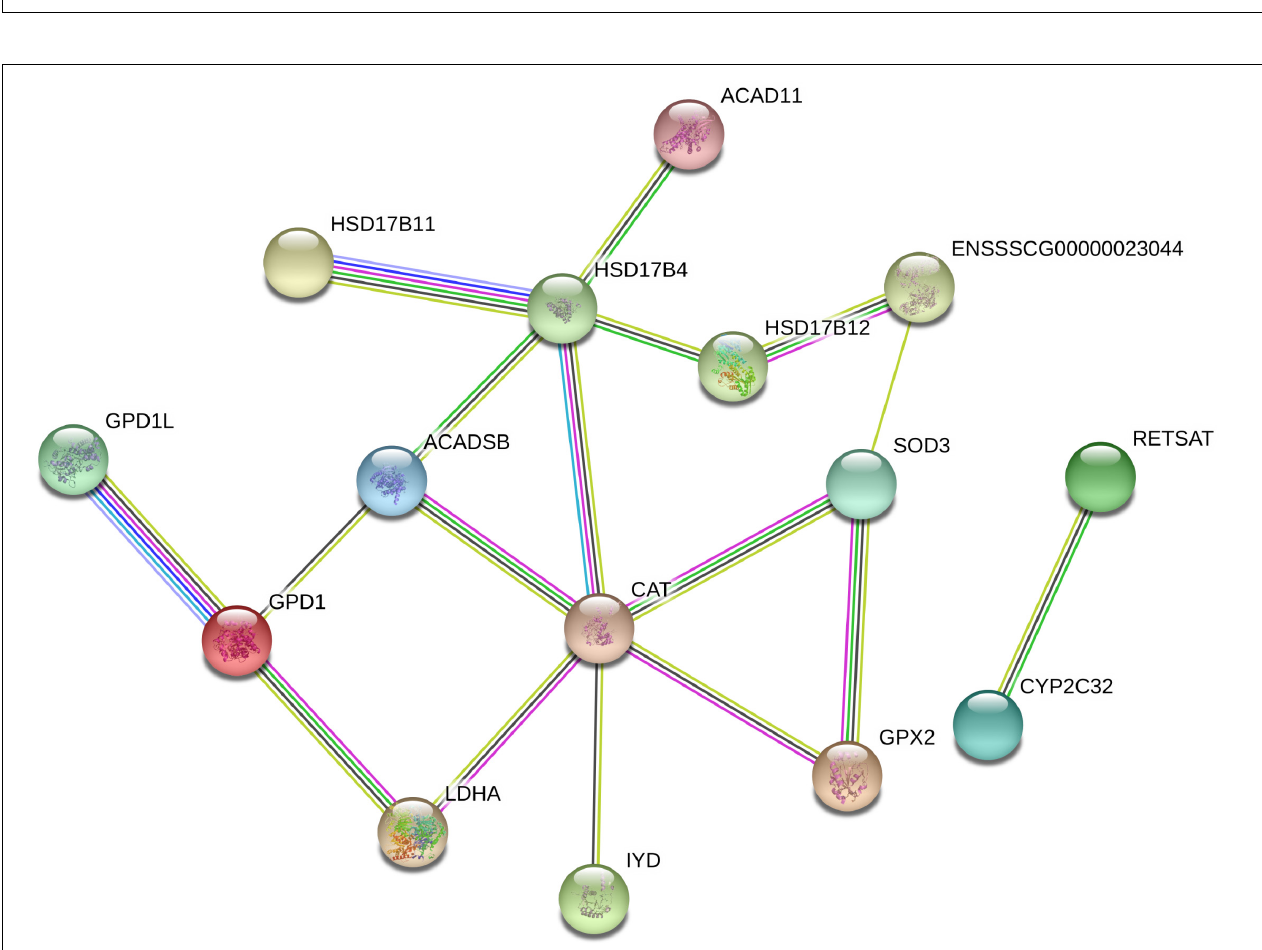
FIGURE 4 | Classification of molecular function in the GO functional enrichment analysis of DEGs. (A) The top 10 terms in the molecular function category. (B) Hierarchical clustering heat maps of DEGs in the GO term of oxidoreductase activity (GO: 0016491). S, sucking piglets; W, weaned piglets.